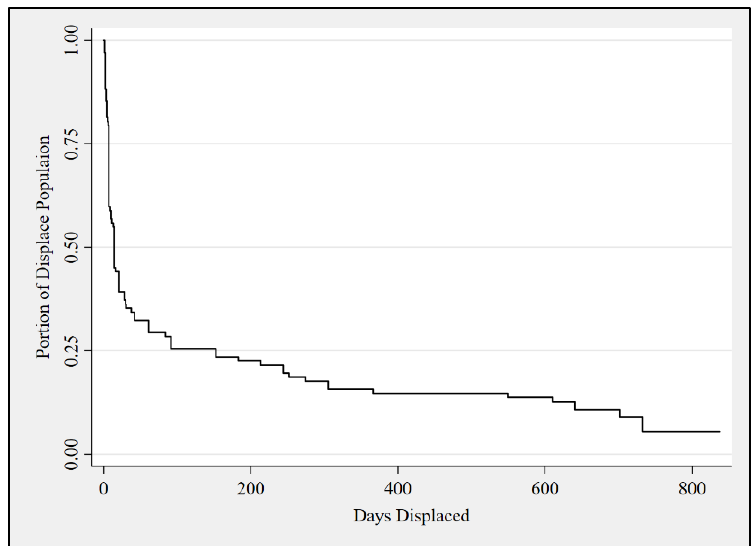
Figure 2. Kaplan – Meier Curve for Displacement Duration. Figure 2. Kaplan–Meier Curve for Displacement Duration.